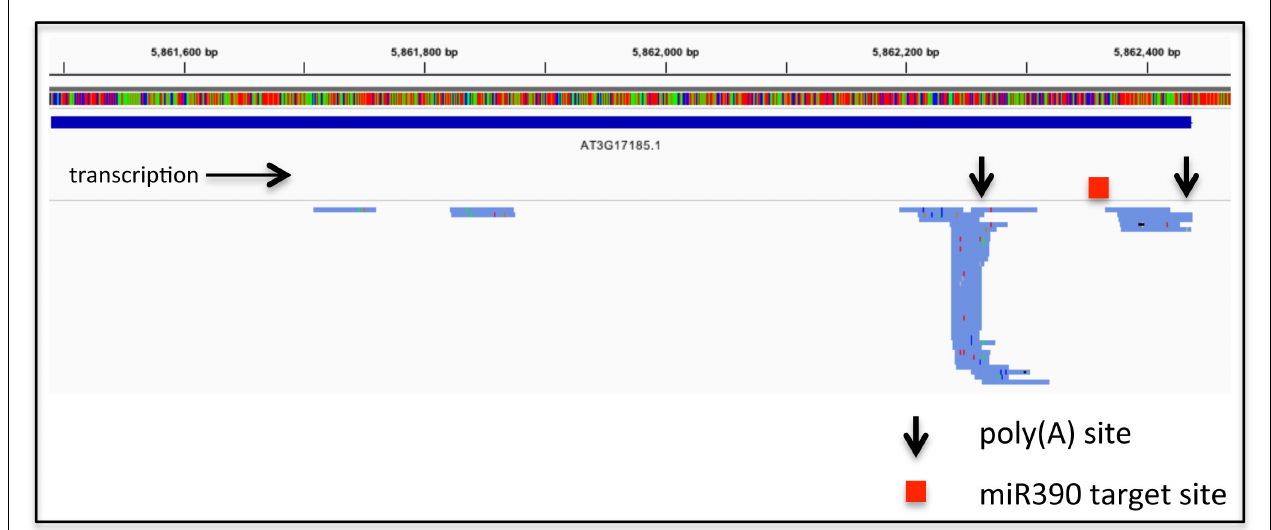
from the Arabidopsis leaf set fromWu et al., 2011) that map to the At3g17185 locus. Colored tics within the tag representations signify differences in sequence from the knownTAS3a sequence; these differences provide an illustration of the error rate inherent in the high-throughput PAT sequencing. The right-most extremity of each tag represents the 3 (cid:2) -end of the tag, and hence the mRNA–poly(A) junction.These tags were mapped to the Arabidopsis genome using CLC GenomicsWorkbench and displayed using the Integrated GenomicsViewer 2.0 (Robinson et al.,